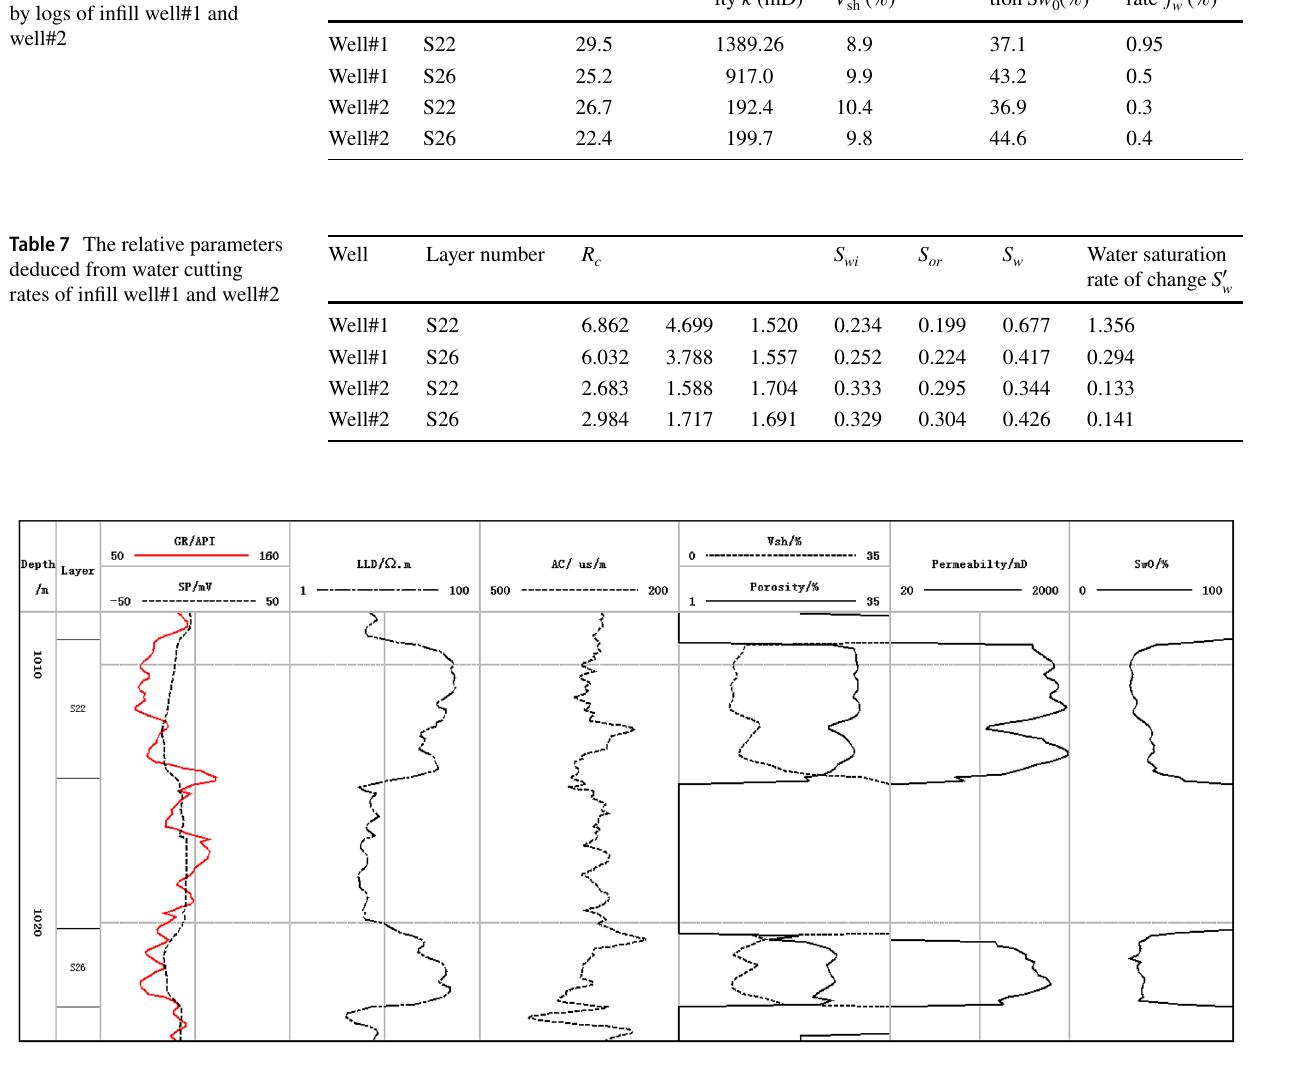
Fig. 8 Logging curves and related parameters calculated by logs of infill well#1. (From the left track to the right track, the first track is well depth, in m; the second track is the layer’s number; the third track is deep dual lateral resistivity log, LLD Ω m; the fourth is